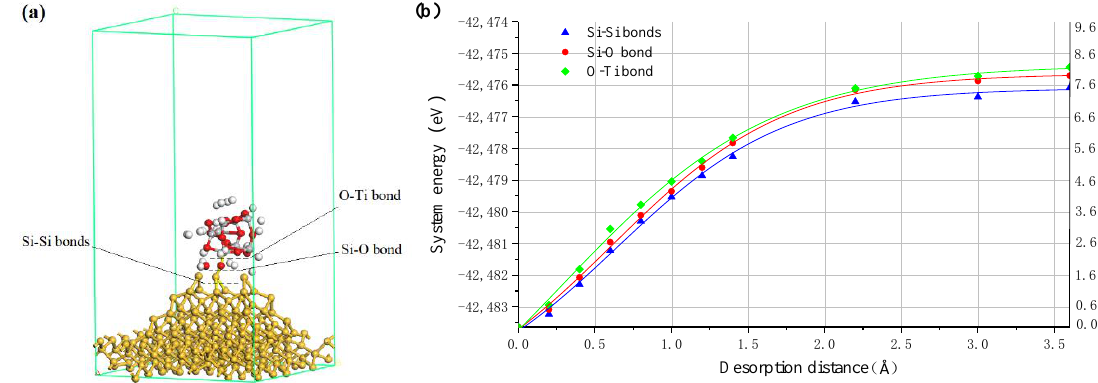
Figure 10. ( a ) Three kinds of bonds between TiO 2 cluster and the Si surface where white, red, grey and yellow balls are hydrogen, oxygen, titanium and silicon atoms, respectively; ( b ) energy curve of TiO 2 cluster separating from Si surface.